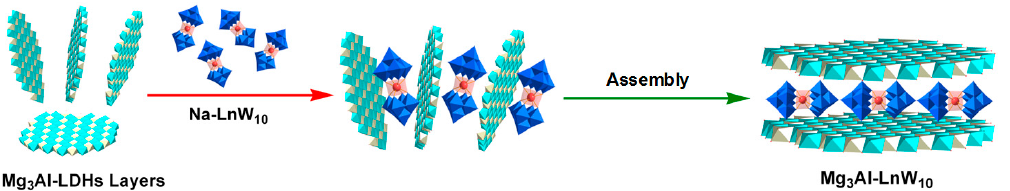
Figure 5. The preparation process of POM ‐ LDHs composites (Mg 3 Al ‐ LnW 10 ) using the Exfoliation assembly method. Reproduced from Ref. [44], Copyright 2014, Elsevier. assembly method. Reproduced from Ref. [44], Copyright 2014,